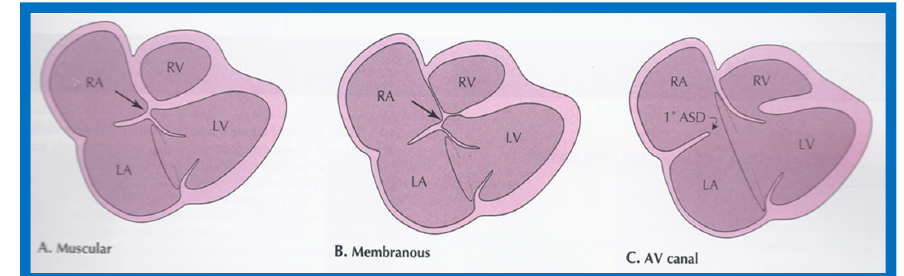
Figure 52. Line drawings demonstrating two dimensional echocardiographic appearances in subcostal four-chamber view of the muscular ( a ), membranous ( b ), and atrioventricular canal ( c ) variants of tricuspid atresia. ( a ) The atretic tricuspid valve is represented by a thick band of echoes between the right atrium (RA) and the small right ventricle (RV) in the muscular type. ( b ) The tricuspid valve is represented by a thin line in the membranous type. Note that crux of the heart (arrows in a and b ) is well seen in both these types ( a and b ). The attachment of the anterior leaflet of the detectable atrioventricular valve to the left side of the interatrial septum is evident. ( c ) In the atrioventricular canal type of tricuspid atresia, the anterior leaflet of the detectable atrioventricular canal is attached to the anterior wall of the heart, occluding the right ventricle from the right atrium and allowing blood exit of both atria into the left ventricle (LV). Crux cordis and the atrioventricular portion of the interventricular septum are not seen. Reproduced from Rao P.S. [15,40].